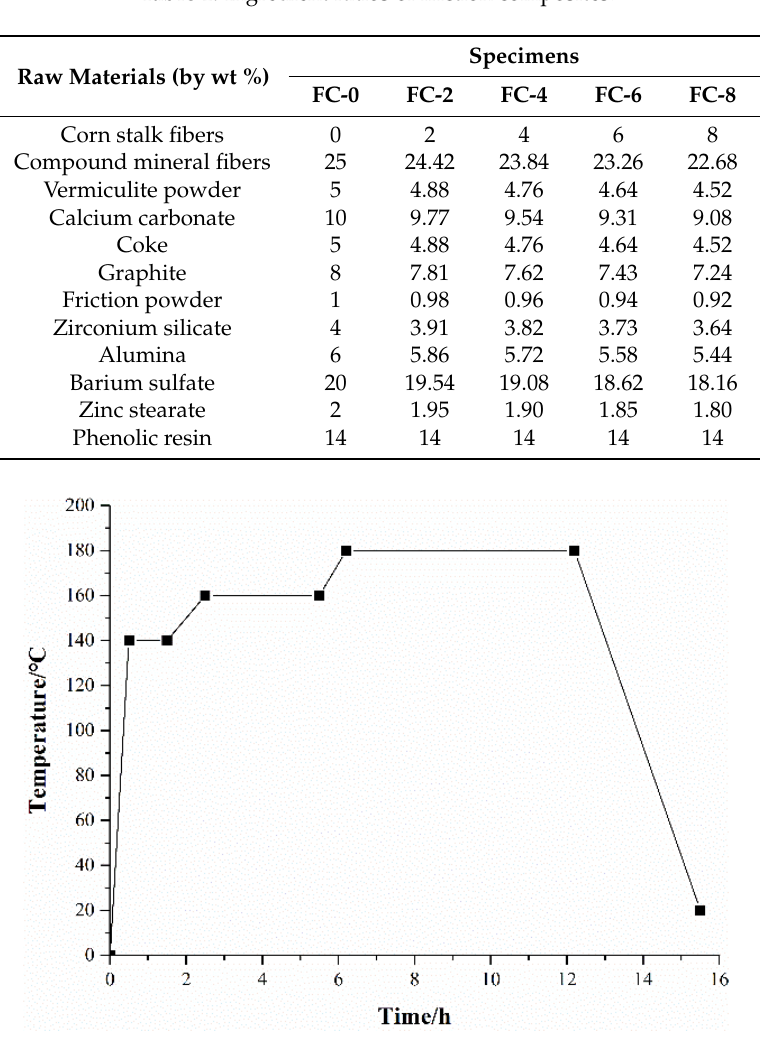
Table 1. Ingredient ratios of friction composites.